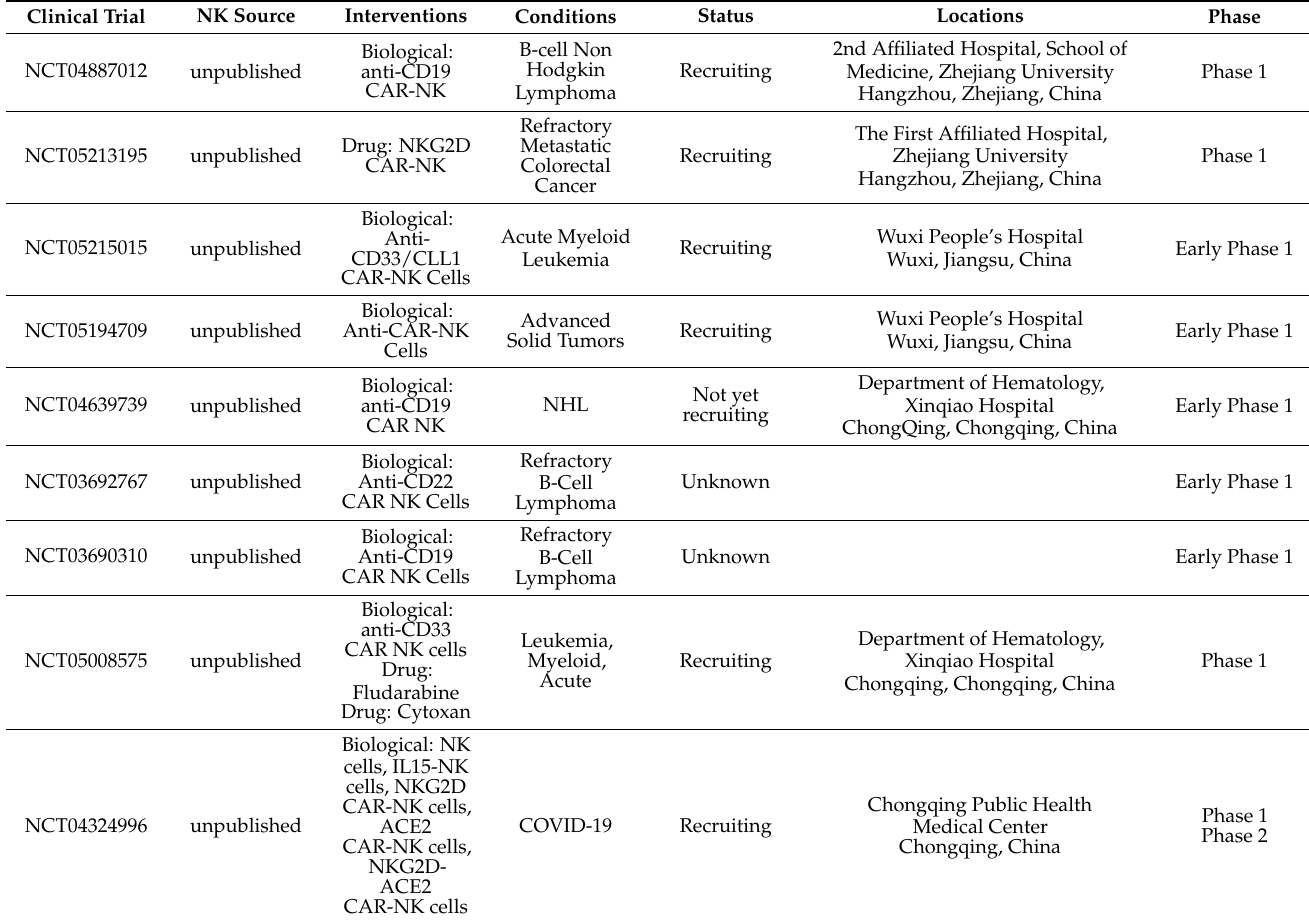
Table 3. Clinical trial summary of CAR-NK